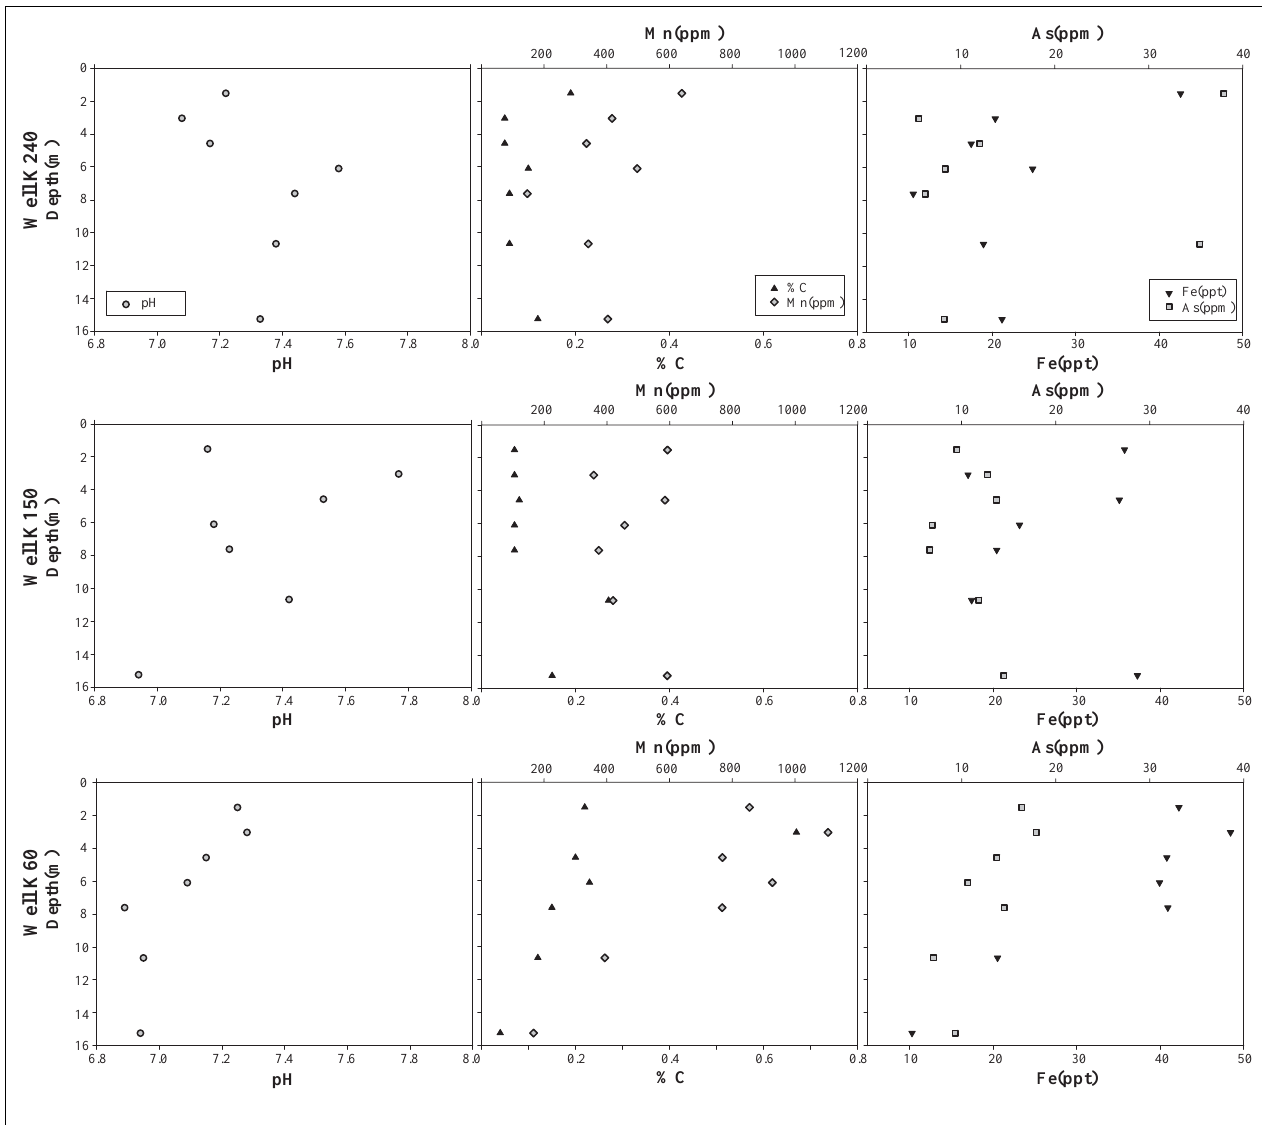
FIGURE 3 | Sediment chemistry at each sampling location along the groundwater